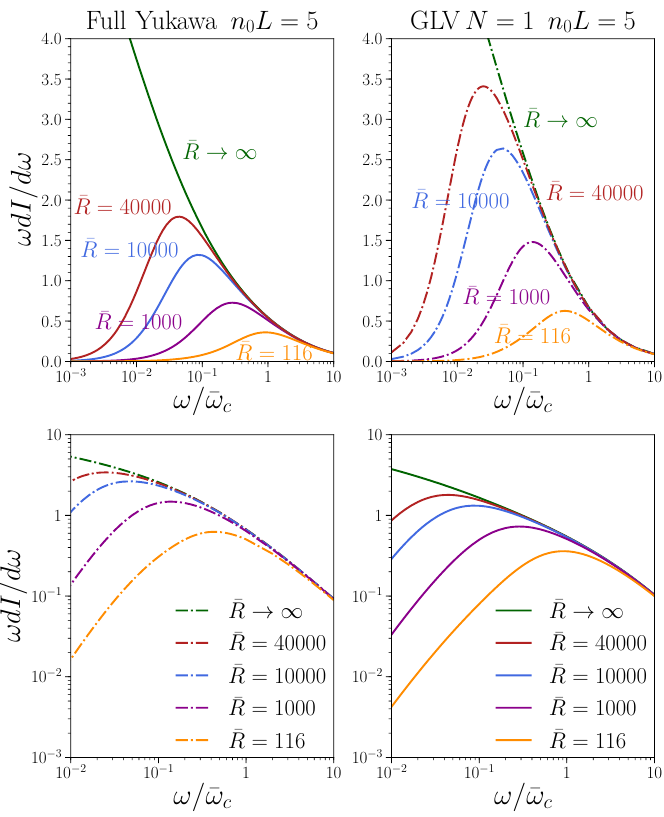
Figure 3 . Top: full medium-induced gluon energy distribution for the Yukawa collision rate (left panel) compared to the GLV (cid:12)rst opacity approximation (right panel) for di(cid:11)erent values of (cid:22) R = (cid:22) 2 L 2 = 2 for a medium with n 0 L = 5 as a function of the rescaled gluon energy != (cid:22) ! c . Bottom: same as top panels in log-log